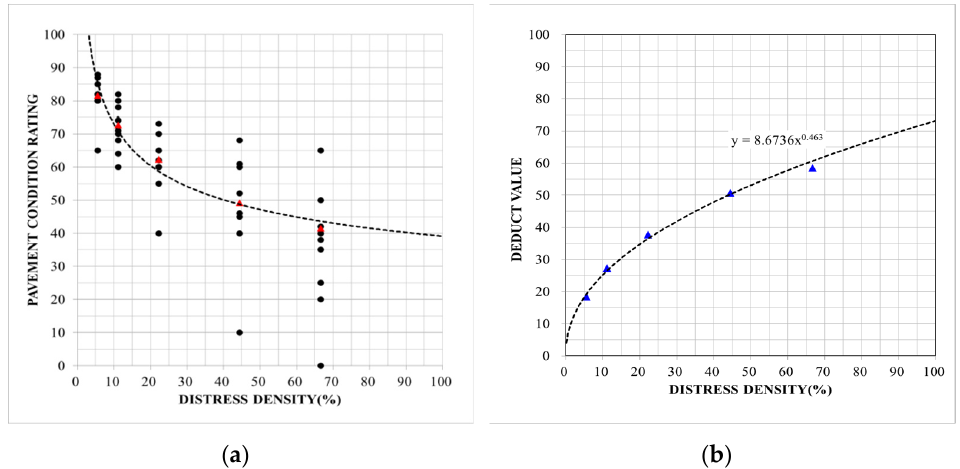
Figure 3. Example showing PCR, DV, and DVC for linear cracking in concrete pavement; ( a ) PCR and average PCR, ( b ) average deduct value and deduct value curve.